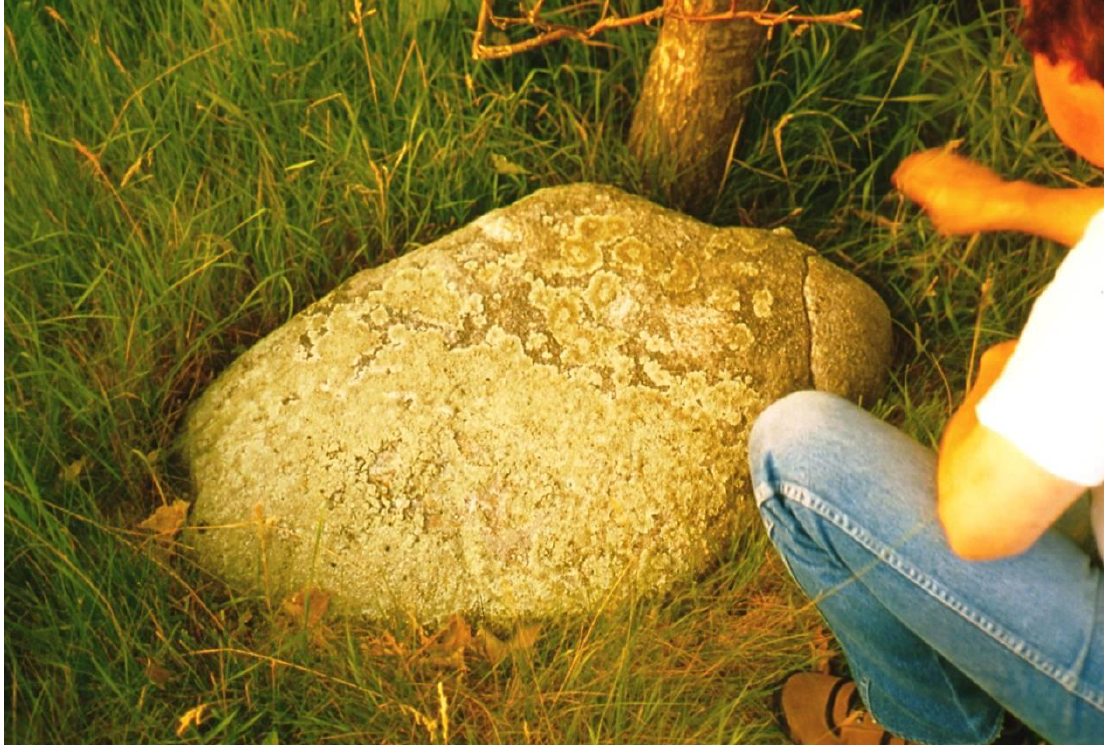
Figure 12. East-facing bison effigy rock on the south end of the hill summit (see Figures 2 and 4). The pronounced hump was enhanced by pecking about its base. The slight knob on the right or top of the head may have represented the horns in profile. The face portion of the rock is now exfoliated, a consequence of time and exposure to the